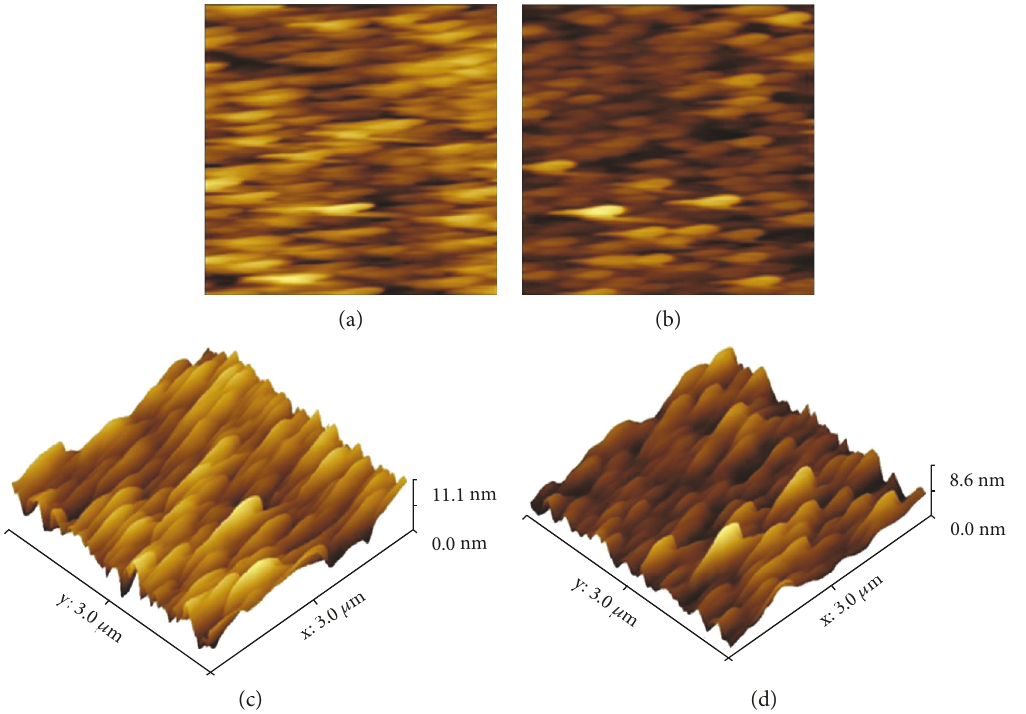
Figure 4: AFM images (3 μ m × 3 μ m) of ZnO fi lms fabricated on (a) the ITO and (b) the MoO and (b),